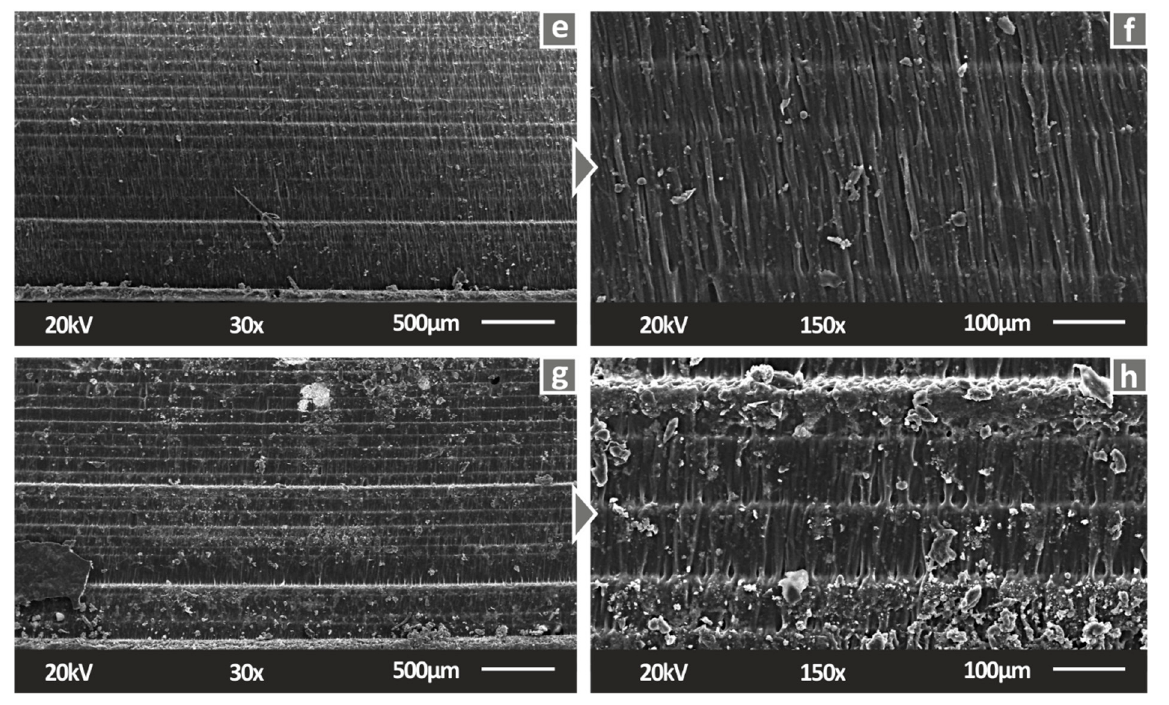
Figure 5. Side surface of tensile specimens in 30× magnification for ( a ) Pure SC, ( c ) SC Cu 2 O 0.5 wt.%, ( e ) SC Cu 2 O 1.0 wt.%, ( g ) SC Cu 2 O 2.0 wt.%, same surfaces in 150× magnification for ( b ) Pure ( e ) SC Cu 2 O 1.0 wt.%, ( g ) SC Cu 2 O 2.0 wt.%, same surfaces in 150 × magnification for ( b ) Pure SC, SC, ( d ) SC Cu 2 O 0.5 wt.%, ( f ) SC Cu 2 O 1.0 wt.%, ( h ) SC Cu 2 O 2.0 wt.%. ( d ) SC Cu 2 O 0.5 wt.%, ( f ) SC Cu 2 O 1.0 wt.%, ( h ) SC Cu 2 O 2.0 wt.%.